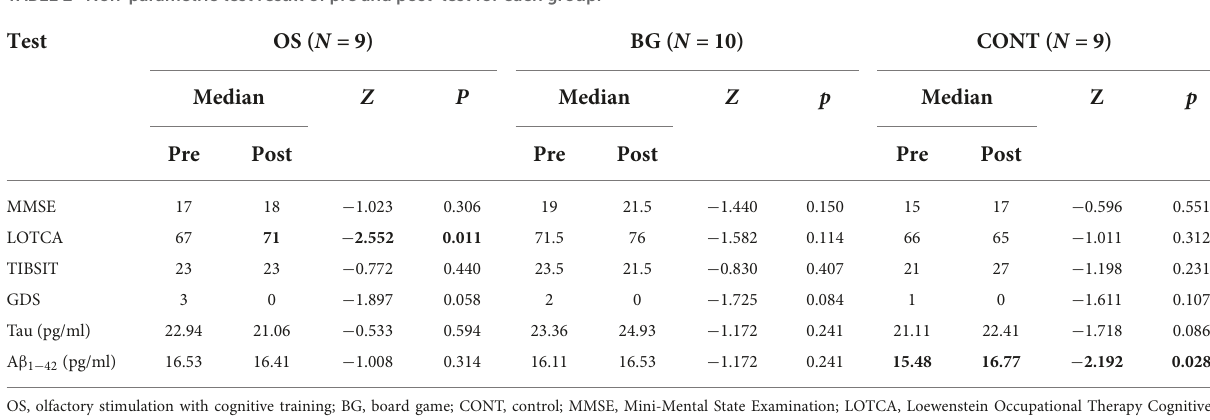
TABLE 2 Non-parametric test result of pre and post-test for each group.